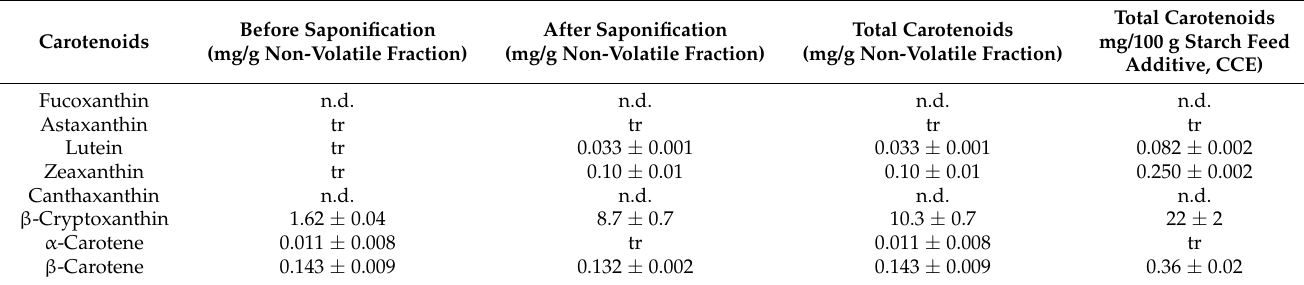
Table 4. Carotenoid composition in the non-volatile fraction of mandarin ( Citrus reticulata ) CPEO.